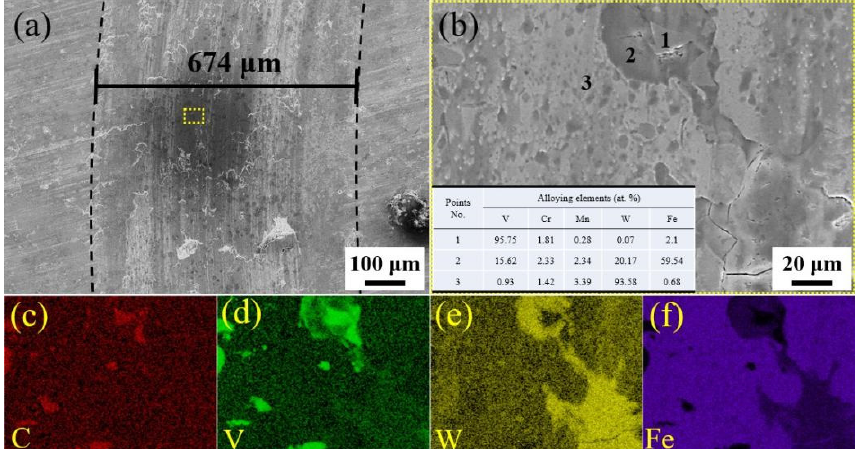
Figure 10. SEM morphologies and the corresponding EDS elemental distribution of wear tracks in the QPT-treated sample. ( a ) SEM image of wear track; ( b ) Magnified morphology of ( a ) in the yellow box with the dotted line; ( c ) Distribution of C element; ( d ) Distribution of V element; ( e ) Distribution of W element; ( f ) Distribution of Fe element.